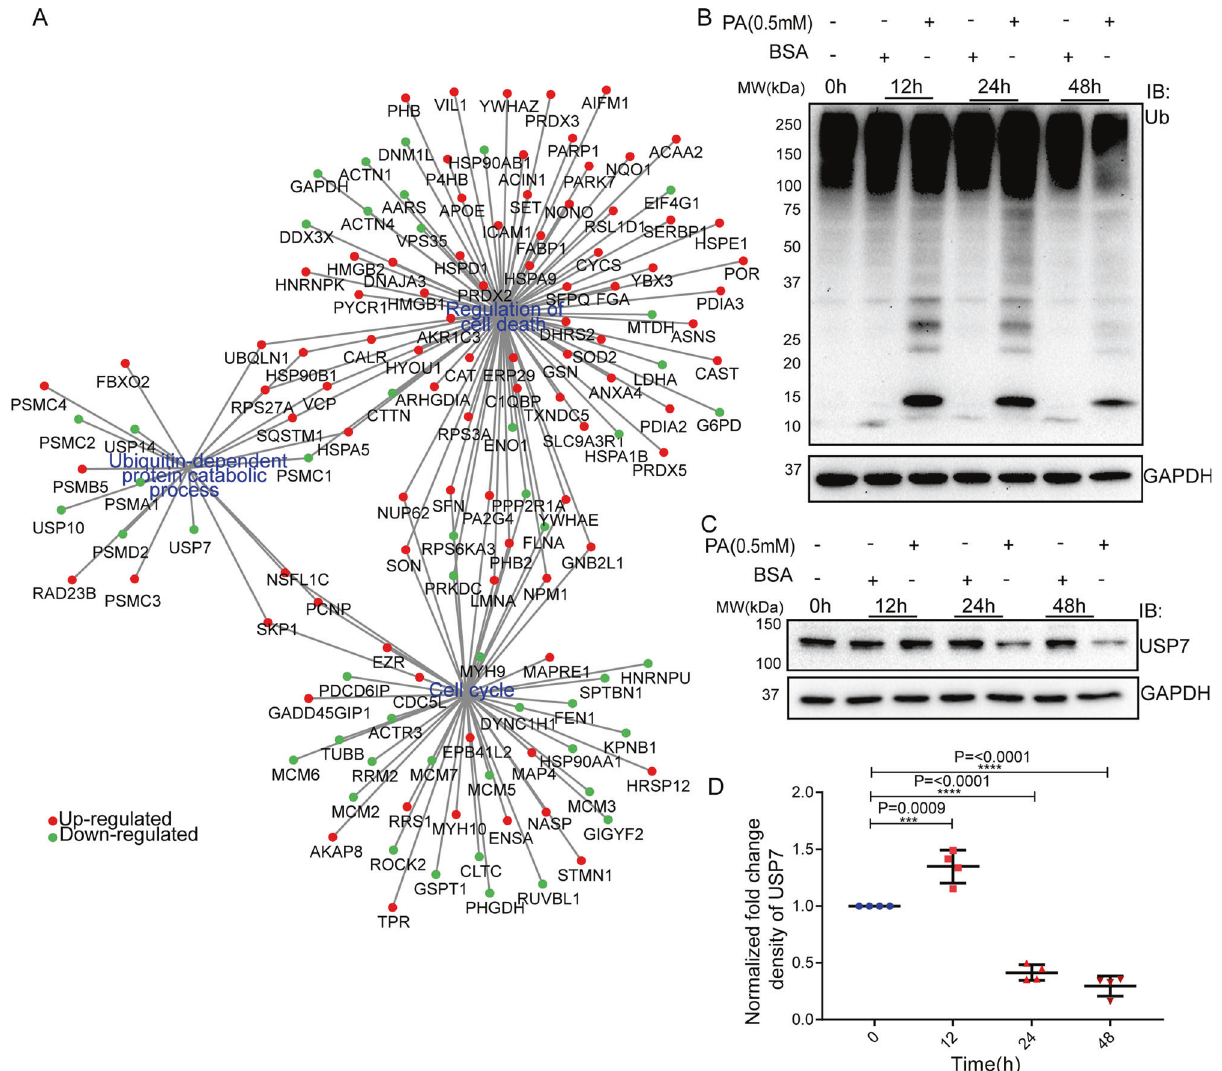
Fig. 2 Palmitic acid deregulates checkpoint-associated DUBs in HepG2 cells. Annotation of differentially regulated network dynamics connected cell cycle and death through ubiquitin-dependent protein catabolic process. The nodes with DEPs of three major networks are represented in PA-induced conditions. Each candidate was represented as a dot, where green and red denote downregulated and upregulated protein, respectively. Overrepresented GO-terms and their matching candidates were retrieved from STRING v11 and reconstructed by Cytoscape ( A ). Time-dependent ubiquitination pattern of HepG2 upon 0.5 mM PA and control vehicle treatment was executed at 0, 12, 24, and 48 h time points. HepG2 cells without any treatment were considered as 0 h. GAPDH was used as a loading control ( B ). PA partially regulated USP7 in HepG2 cells. Same lysates were subjected to SDS-PAGE and immune-blotted with USP7 antibody ( C ). In blot, an untreated cell at 0 h signi fi es a healthy condition. GAPDH was used as a loading control. Each time-dependent expression was normalized by GAPDH, and fold change intensity was normalized by individual BSA-treated conditions of a particular time point. Quanti fi cation of protein expression was represented by dot plot ( D ). Ordinary one-way ANOVA followed by Tukey ’ s multiple comparisons test was applied for statistical analysis. Error bars are showing mean ± SEM; n ≥ 3; * p ≤ 0.05; ** p ≤ 0.01; **** p ≤ 0.0001, and ns = non-signi fi